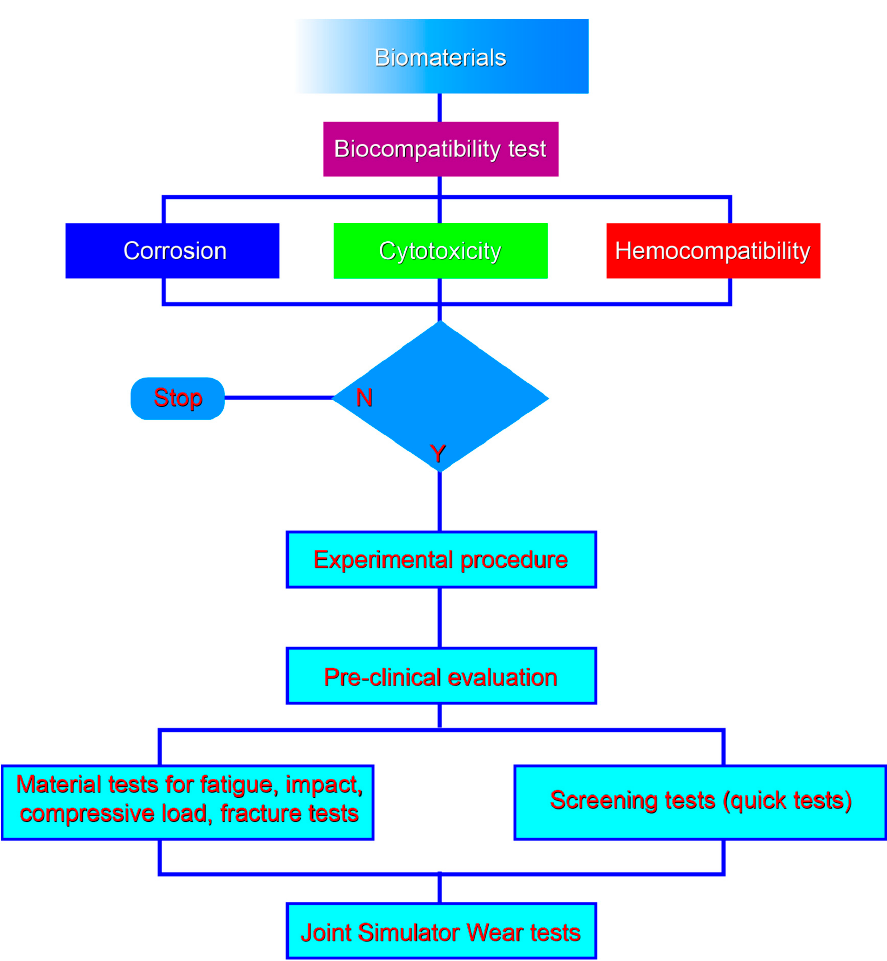
Figure 1. Flow chart showing the characterization of a new biomaterial.